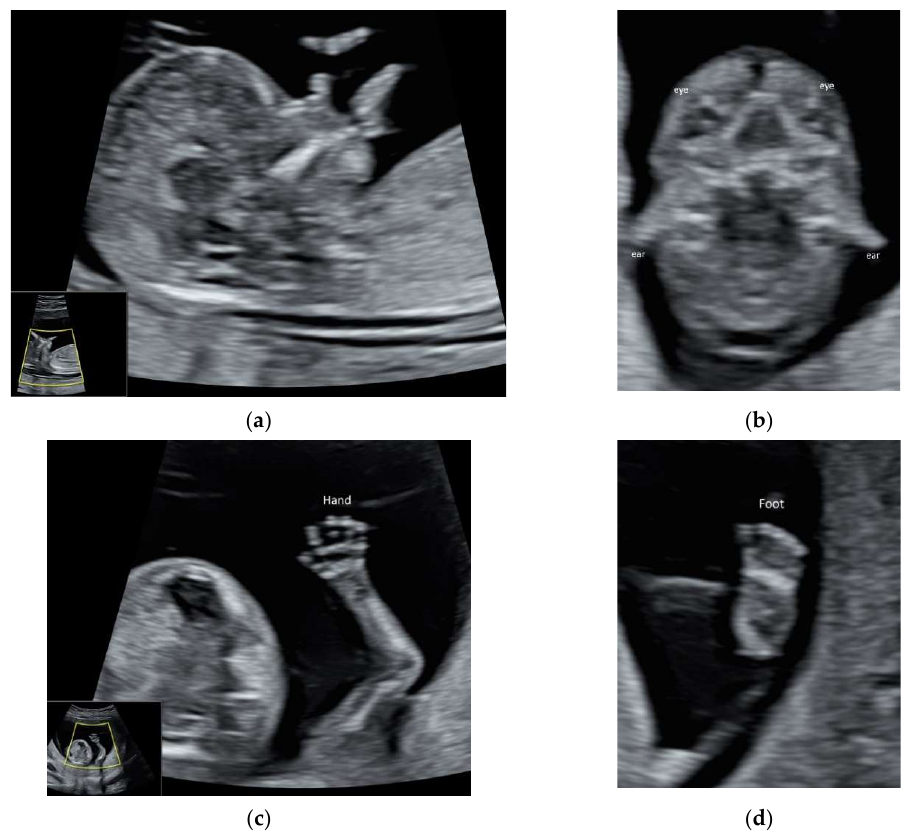
Figure 5. High-resolution ultrasonography of the fetus at 13 weeks’ gestation: ( a ) mid-sagittal view showing head, neck, and facial profile, ( b ) coronal view showing both eyes and ears, ( c ) the hand with five fingers, and ( d )